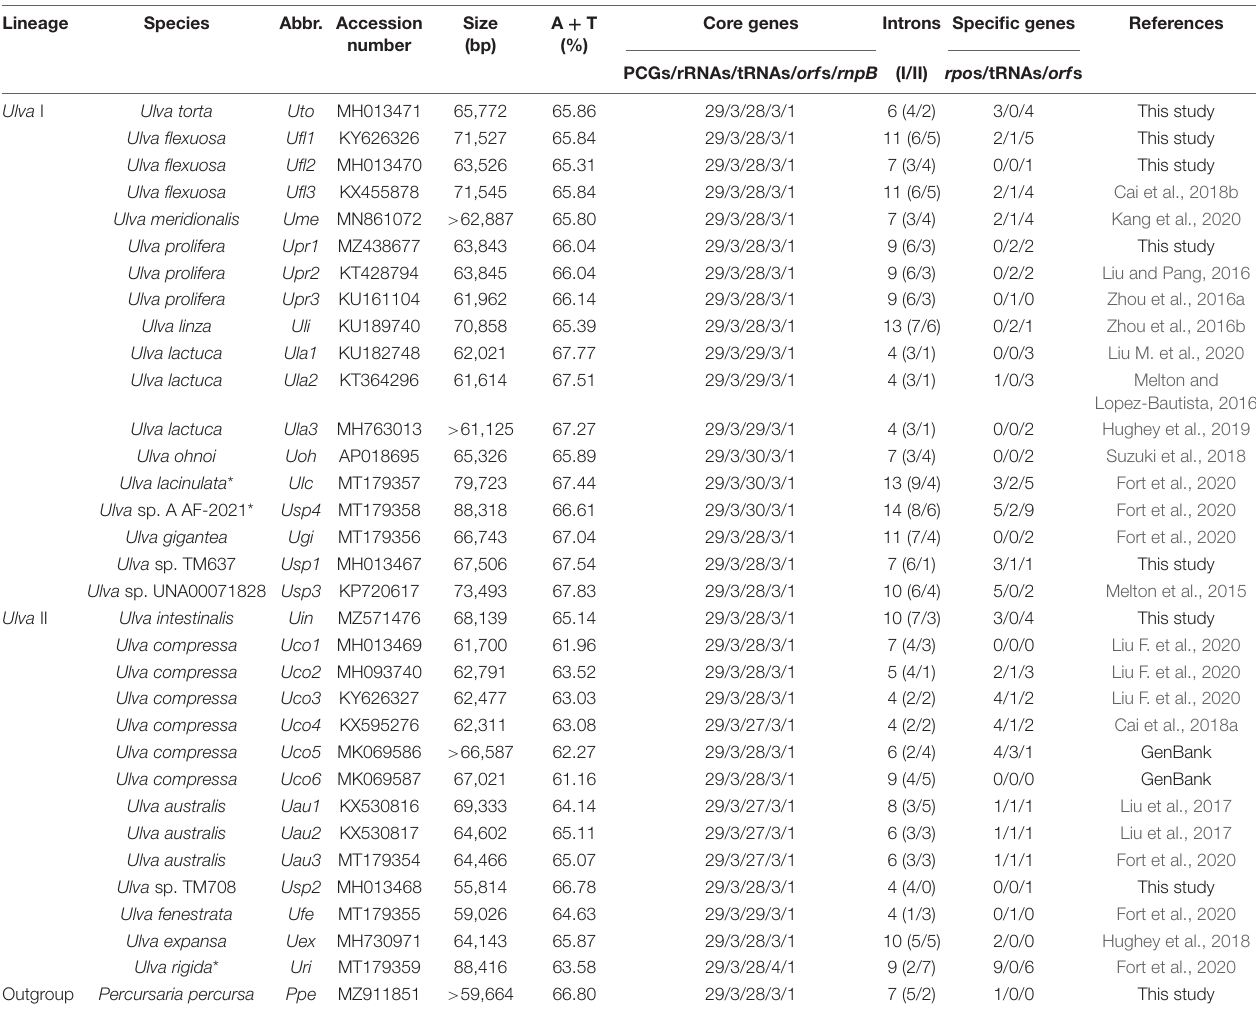
TABLE 1 | General features of 33 ulvalean mitochondrial genomes from 19 Ulva species and one Percursaria species for comparative